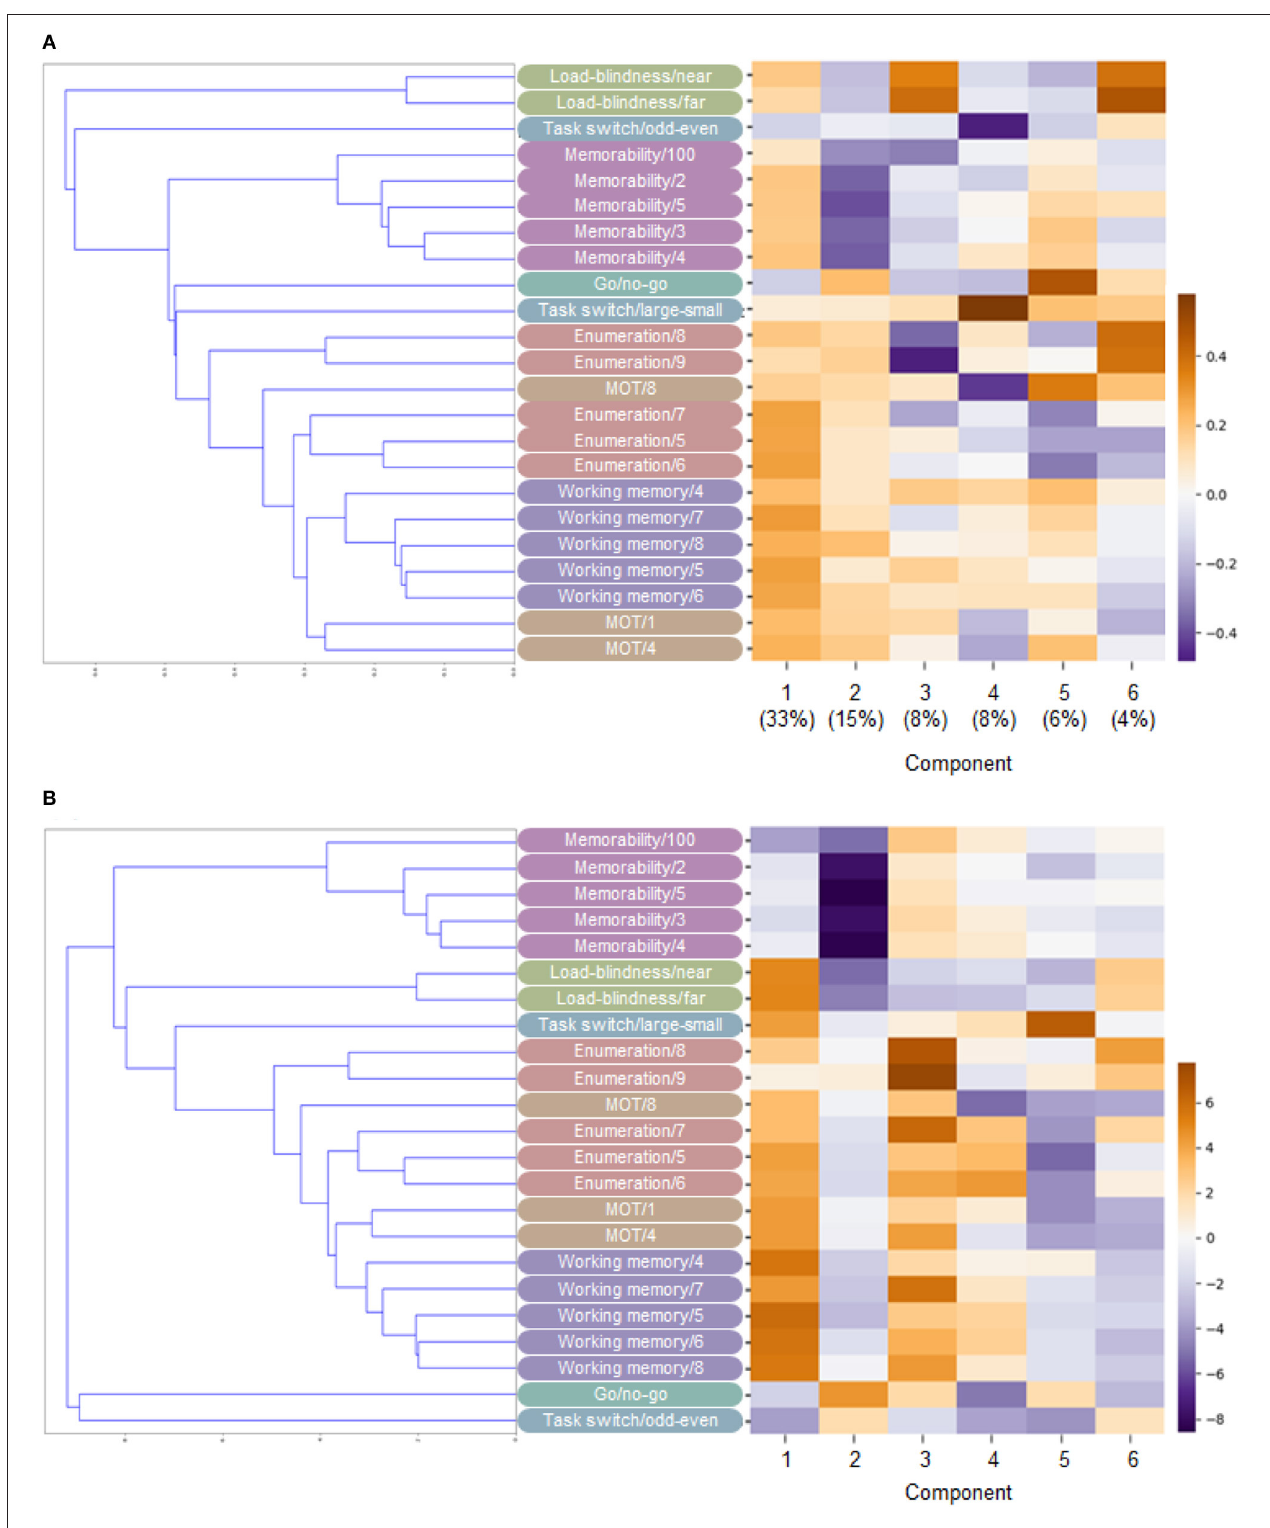
FIGURE 9 | The hierarchical clustering and the loading in (A) PCA and (B) ICA. The components in PCA are numbered in order of the magnitude of the explained variance, as in the legend. The component order in ICA is arbitrary because the analysis does not have the priority of the order.